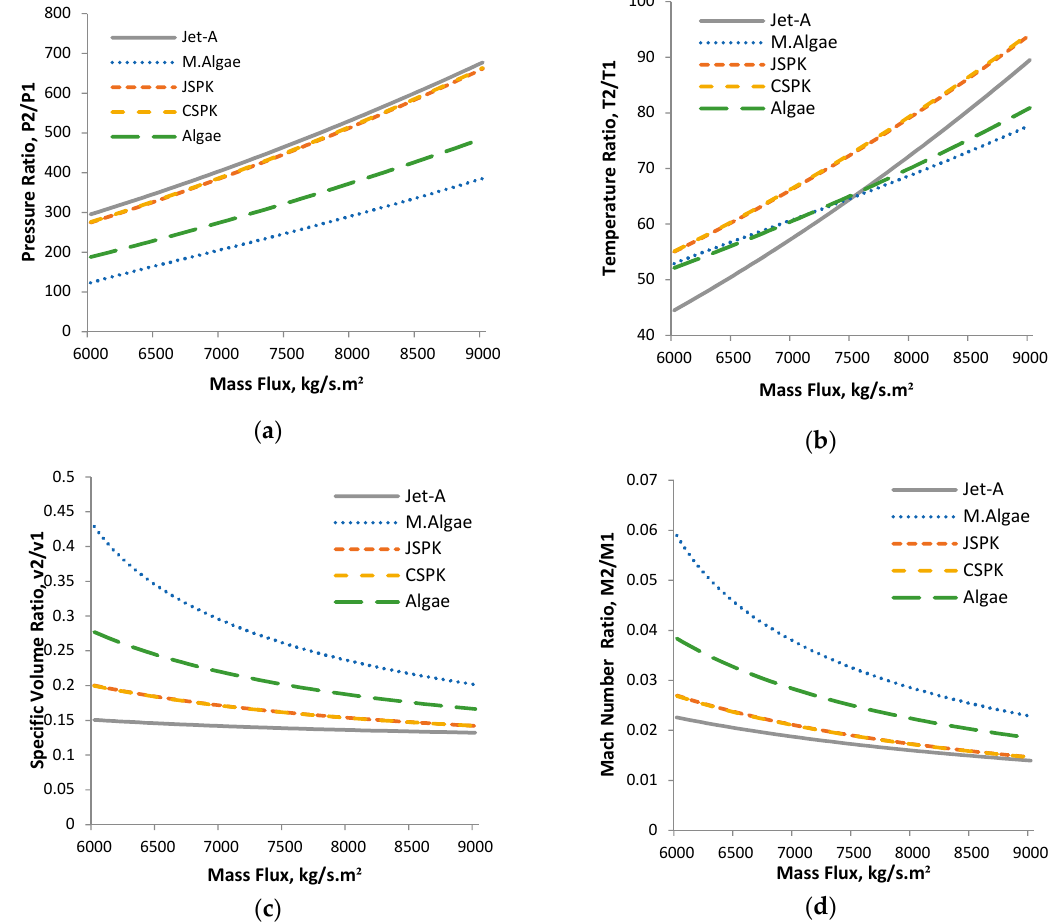
Figure 5. Comparison of ( a ) pressure ratios; ( b ) temperature ratios; ( c ) specific volume ratios; ( d ) and Mach number ratios at different initial mass flux under influence of strong detonation (P = 1 atm, T = 2000 K).